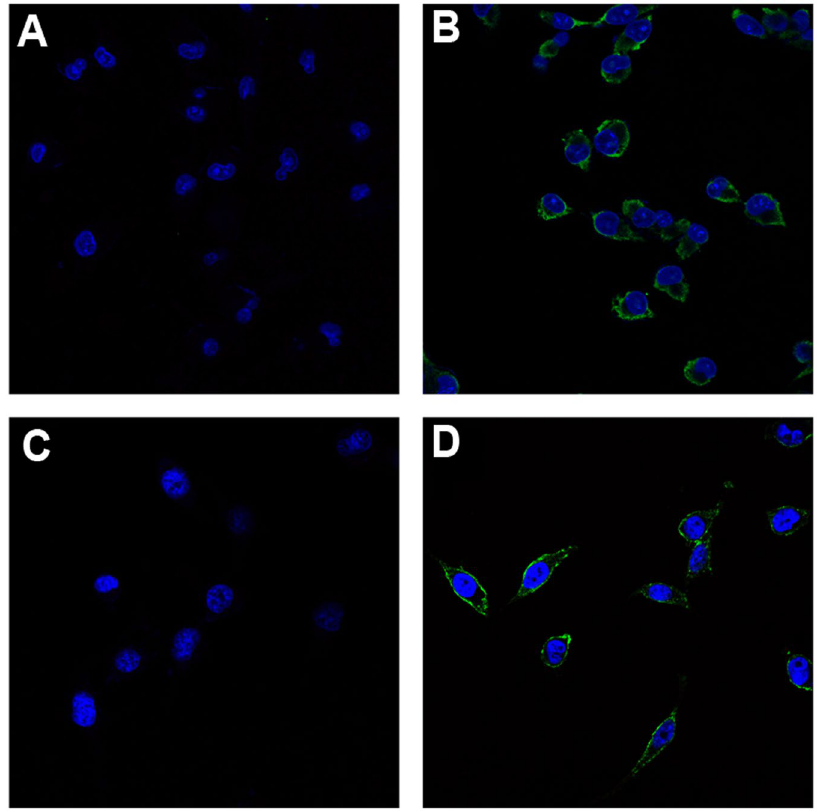
Figure 1. Immunofluorescence detection of irisin receptors on pancreatic cancer cell membrane. Images were taken using the confocal fluorescence microscope. MIA PaCa-2 ( A , B ) and Panc03.27 ( C , D ) cells were previously treated with or without irisin and incubated with anti-irisin rabbit antibody and fluorescein FITC (green) conjugated secondary antibody. Cell nuclei were stained with Honchest 33258 (blue). ( A , C ) Immunofluorescence staining of control cells that were treated without irisin. Green fluorescence was not observed on the cell membrane of control cells. ( B , D ) Visible green fluorescence was observed on the membrane of cells pretreated with irisin. The presence of green fluorescence indicates the presence of irisin receptors on the membranes of MIA PaCa-2 and Panc03.27